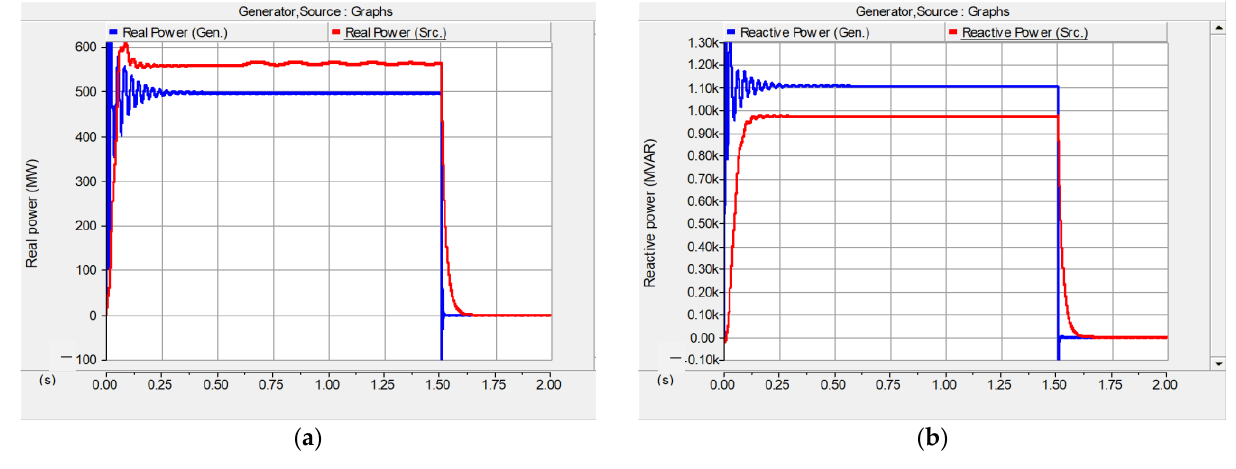
Figure 29. ( a ) Real power; ( b ) reactive power.